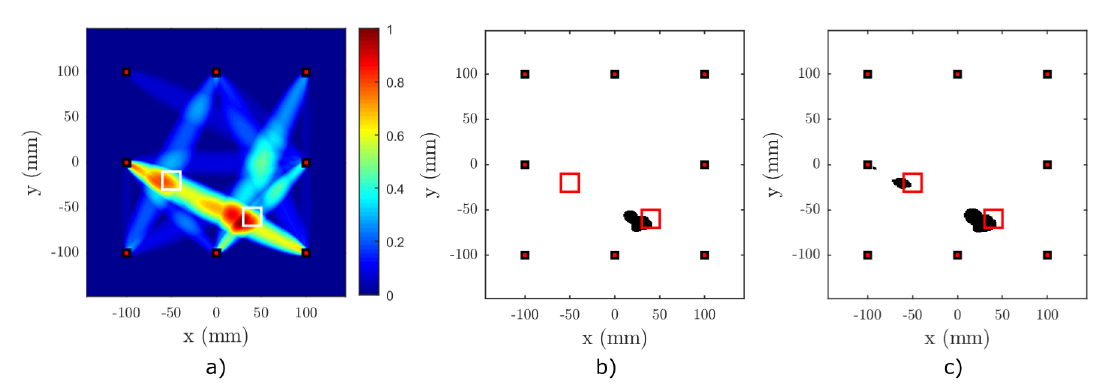
Figure 8. Result of Test Case 3 for nonlinear RAPID imaging on a simulated anisotropic plate, ( a ) without binarization, ( b ) with binary thresholding ( t P = 0.8) and ( c ) with lowered binary threshold ( t P = 0.75). The centers of the delaminations are located at [ − 50, − 20] and [40, − 60]. The shape factor is set to β = 1.015 and the SDC threshold to t SDC = 0.25. The actual location of the delamination is marked with white squares in (a) and a red square in (b,c).